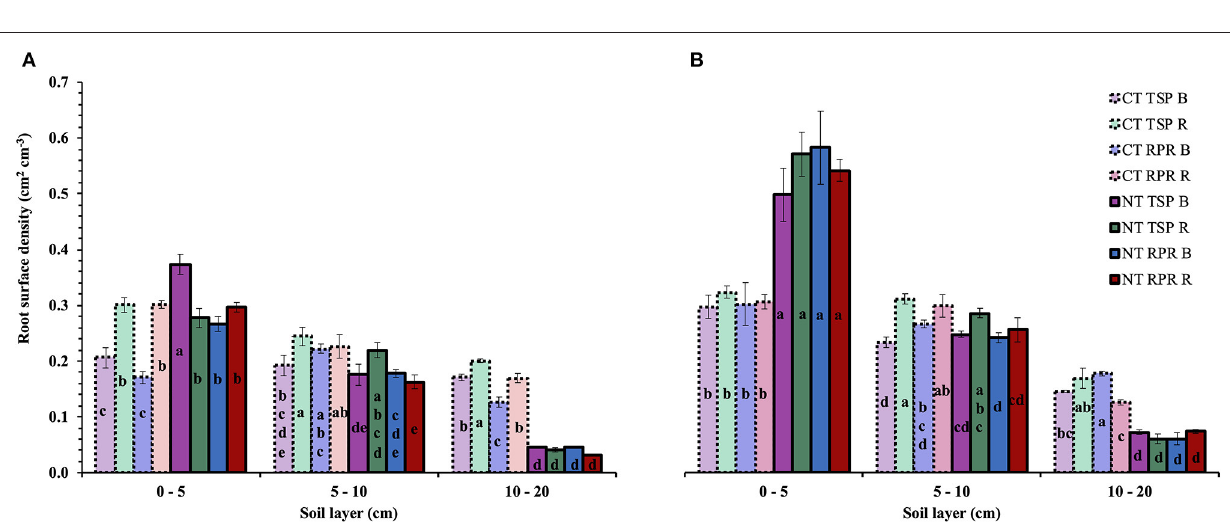
RPR at 0–5 cm for broadcast application and 5–10 cm for row application ( Figure 3A